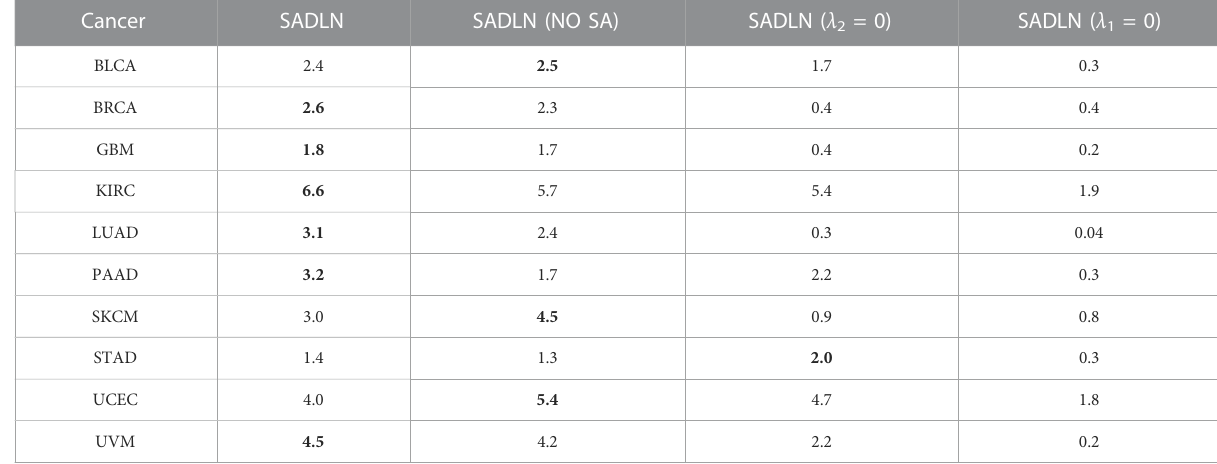
TABLE 3 The − log10 p values of ablation studies in ten cancer datasets on TCGA (bold indicates that this method performs best on the corresponding cancer dataset). Cancer